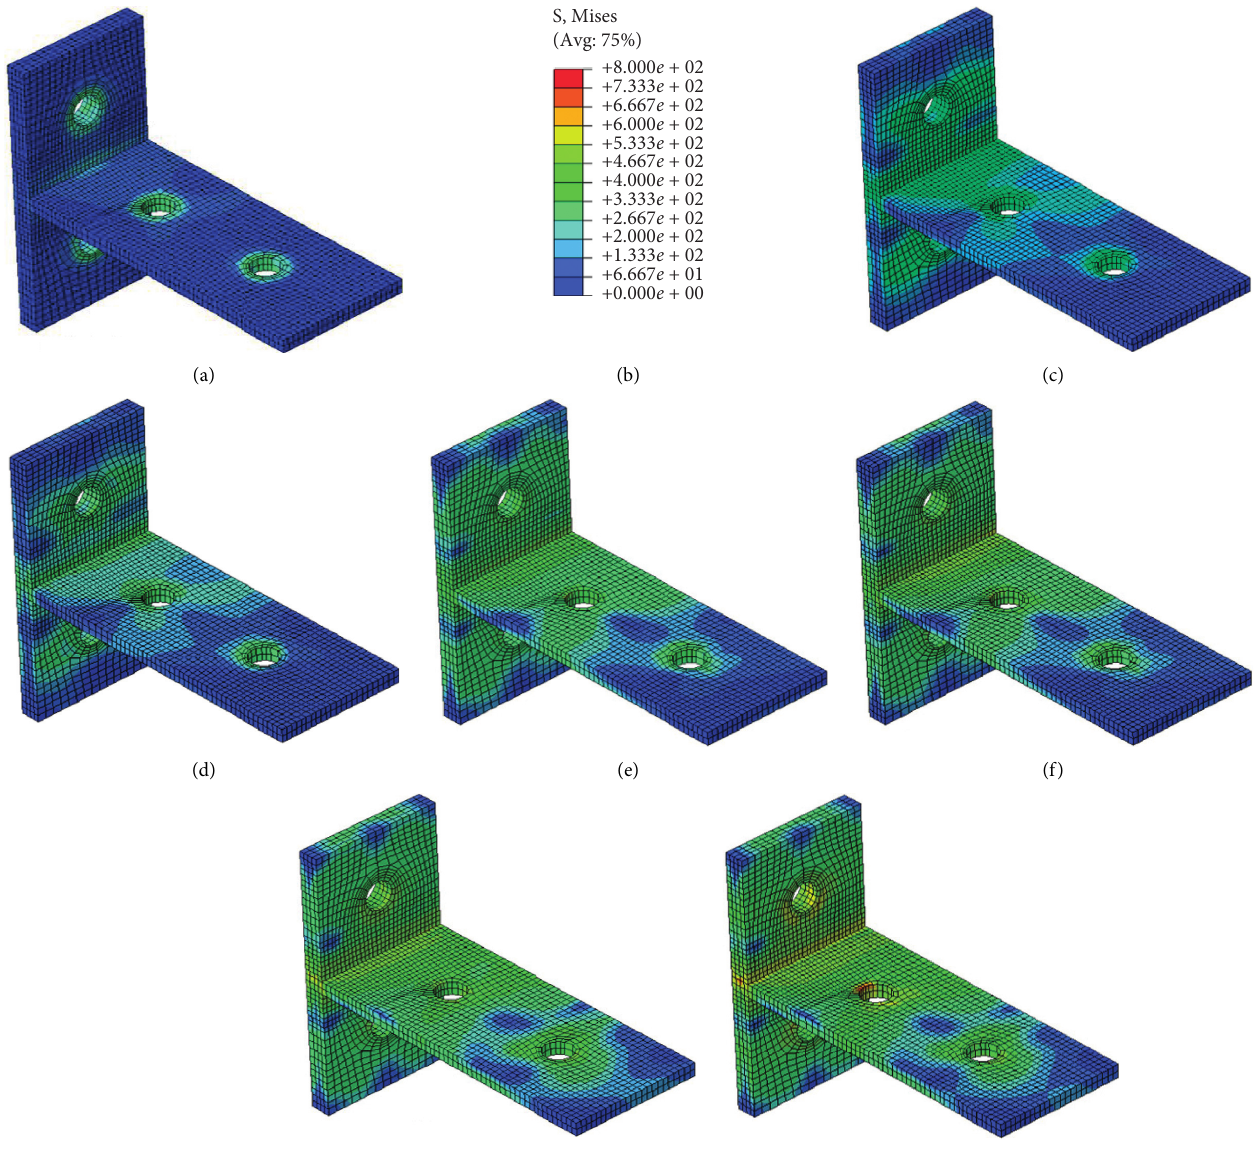
Figure 11: Mises stress σ mi contour plots for T t T-stub. The above contour plots are those obtained when the displacement is at the loading � 5 , 20 , 35 , 60 { } ; Δ ∈ d represents the IHM-S result, and Δ C represents the CHM-S result. (a) ( L 1) Δ point Δ 1st , + con I